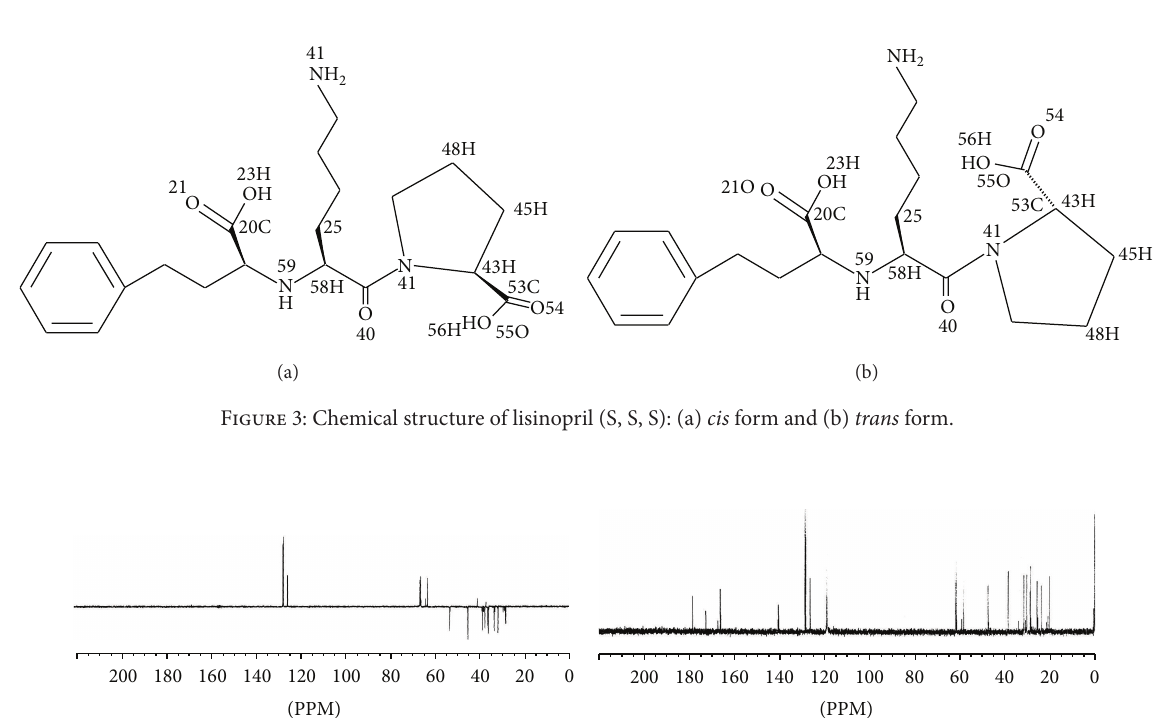
Figure 2: Effect of column temperature on the peak shape of lisinopril; mobile phase: phosphate buffer, [pH 7]/acetonitrile (90: 10, v/v); flow rate: 2.0 mL/min; stationary phase: Supelco LC18, 5 𝜇 m ( 250 × 4.6 mm I.D.). (a) 𝑇 = 279 K, (b) 𝑇 = 328 K.